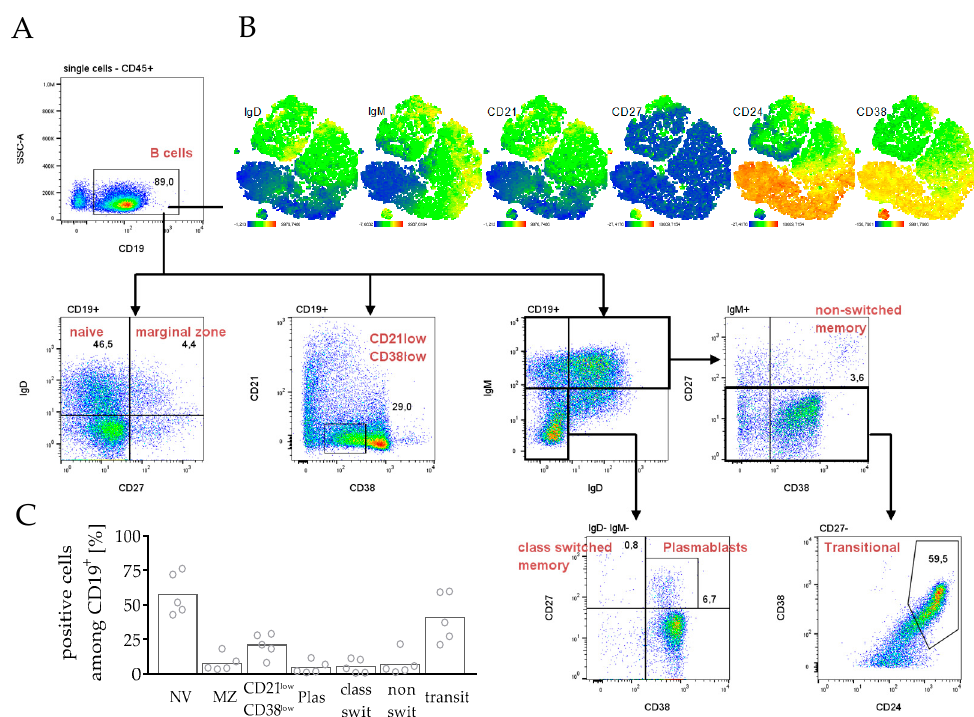
Figure 3. Immune profiling and gating strategy for phenotyping B cell subpopulations in spleens of hPDXs. PDX tumors from breast cancer patients were transplanted orthotopically in humanized NSG mice. Splenocytes were analyzed by flow cytometry. ( A ) Gating strategy for flow cytometry analysis of human splenocytes was as follows: singular (FSC-A FSC-W low , CD45 + , human) B cells (CD19 + ), were analyzed free from murine CD45 + cells regarding the B cell subset markers CD21, CD24, CD38, CD27, IgD, and IgM. ( B ) Clustering of human B cells was calculated by t-SNE analysis, color-coded by the expression of different conventionally B cell markers as indicated. t-SNE map of one exemplary mouse is shown. ( C ) Analyses of B cell subpopulations of all hPDX are summarized: Naïve (NV) B cells (IgD + CD27 − ), marginal zone (MZ) B cells (IgD + CD27 + ), CD21 low CD38 low B